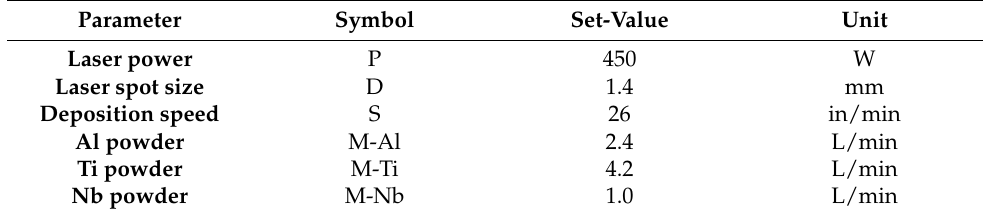
Table 1. DED process parameters.